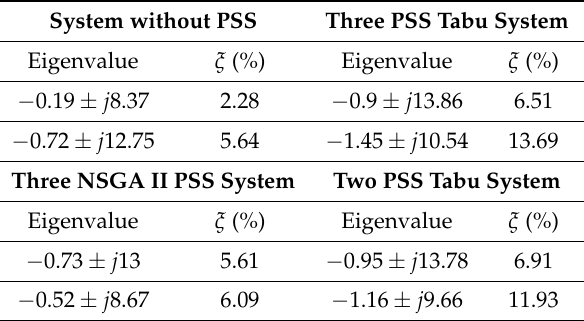
Table 4. Eigenvalues associated with the electrochemical variables of the system without PSS and the three cases